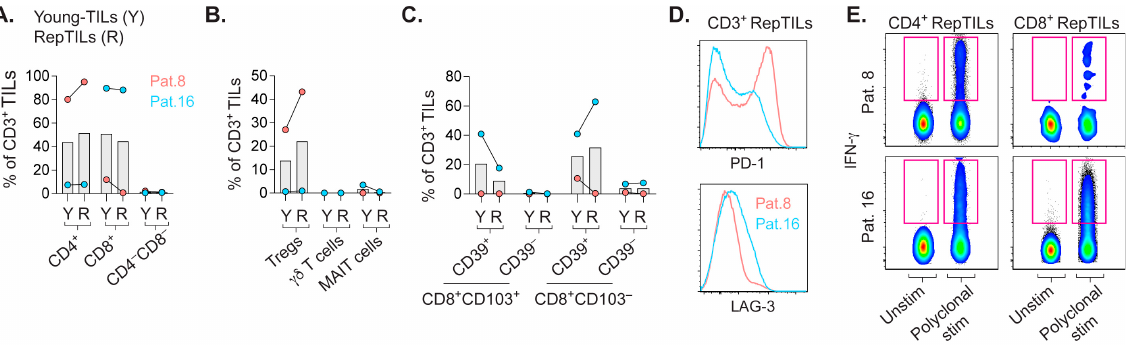
Figure 3. Phenotypic and functional assessment of in vitro–expanded TILs. ( A ) Frequency of CD4+, CD8+ or CD4 − CD8 − TILs among CD3+ young-TILs or RepTILs from patients 8 and 16, respectively. Frequency of Tregs and unconventional TILs ( B ), plus CD8+CD103+ T RM cells and CD8+CD103 − TILs expressing CD39 or not ( C ). ( D ) Histograms of PD-1 and LAG-3 on total RepTILs. ( E ) IFN- γ expression by RepTILs after polyclonal stimulation with microbeads loaded with anti-CD2/CD3/CD28 antibodies or cultured in medium alone (unstim). Bars show the mean.